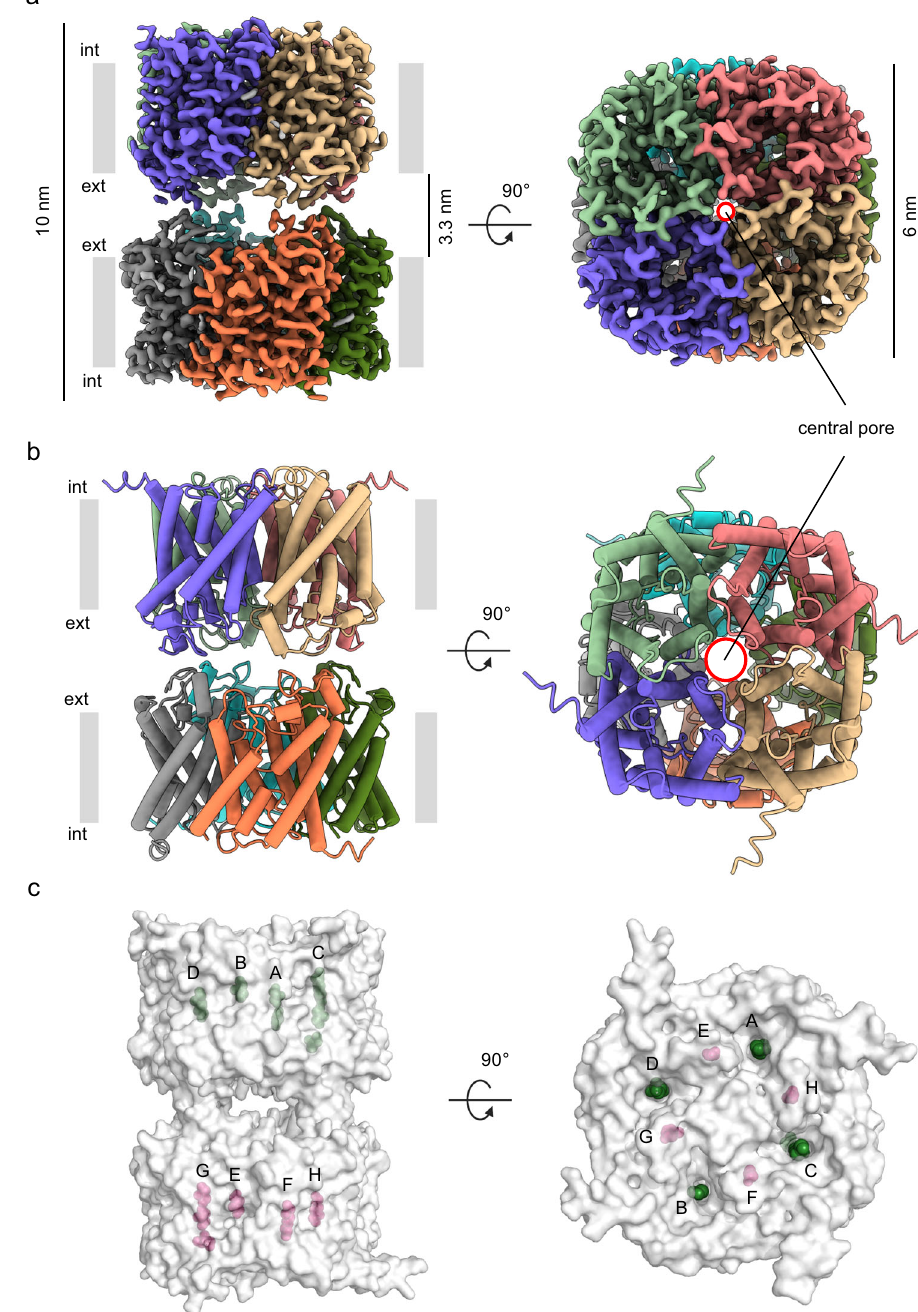
Fig. 2| Structuraloverview ofthetwoadheringtetramersofAQP7 determined by cryo-EM.a Side and top views of the3.0Åmap ofAQP7,generatedbyapplying C1 symmetry.The mapiscoloredbychain. b Sideand top viewsof the modelwere generated using the 3.0Å data. The model is shown as cylindrical helices and colored by chain. The central pore in the top view (from the cytoplasm) is marked